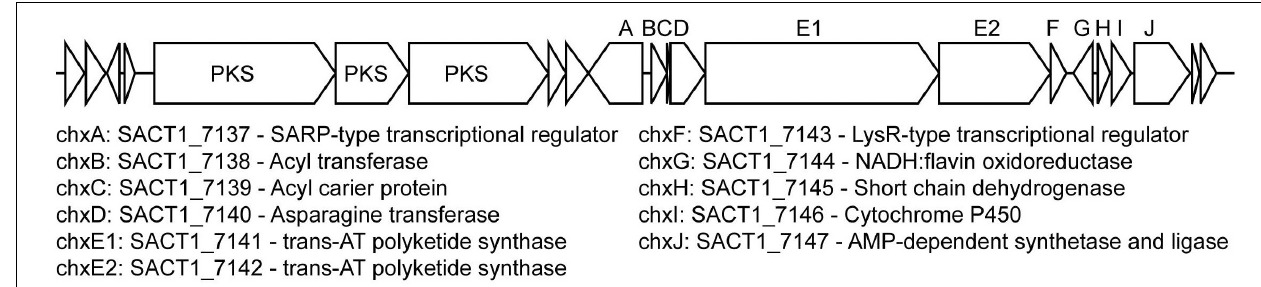
FIGURE 7 | Putative cycloheximide biosynthetic gene cluster in S. griseus XylebKG-1, predicted using antiSMASH v2.0, homology to a cycloheximide biosynthetic gene cluster from Streptomyces sp. YIM56141, and retrobiosynthetic logic. Letters above the cluster indicate gene names, with corresponding locus names and annotations indicated below. An upstream biosynthetic gene cluster predicted to be unrelated to cycloheximide biosynthesis is also shown, with its polyketide synthase (PKS) genes indicated.